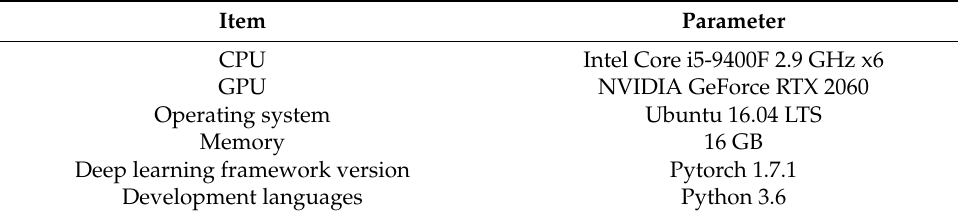
Table 1. Experimental environmental